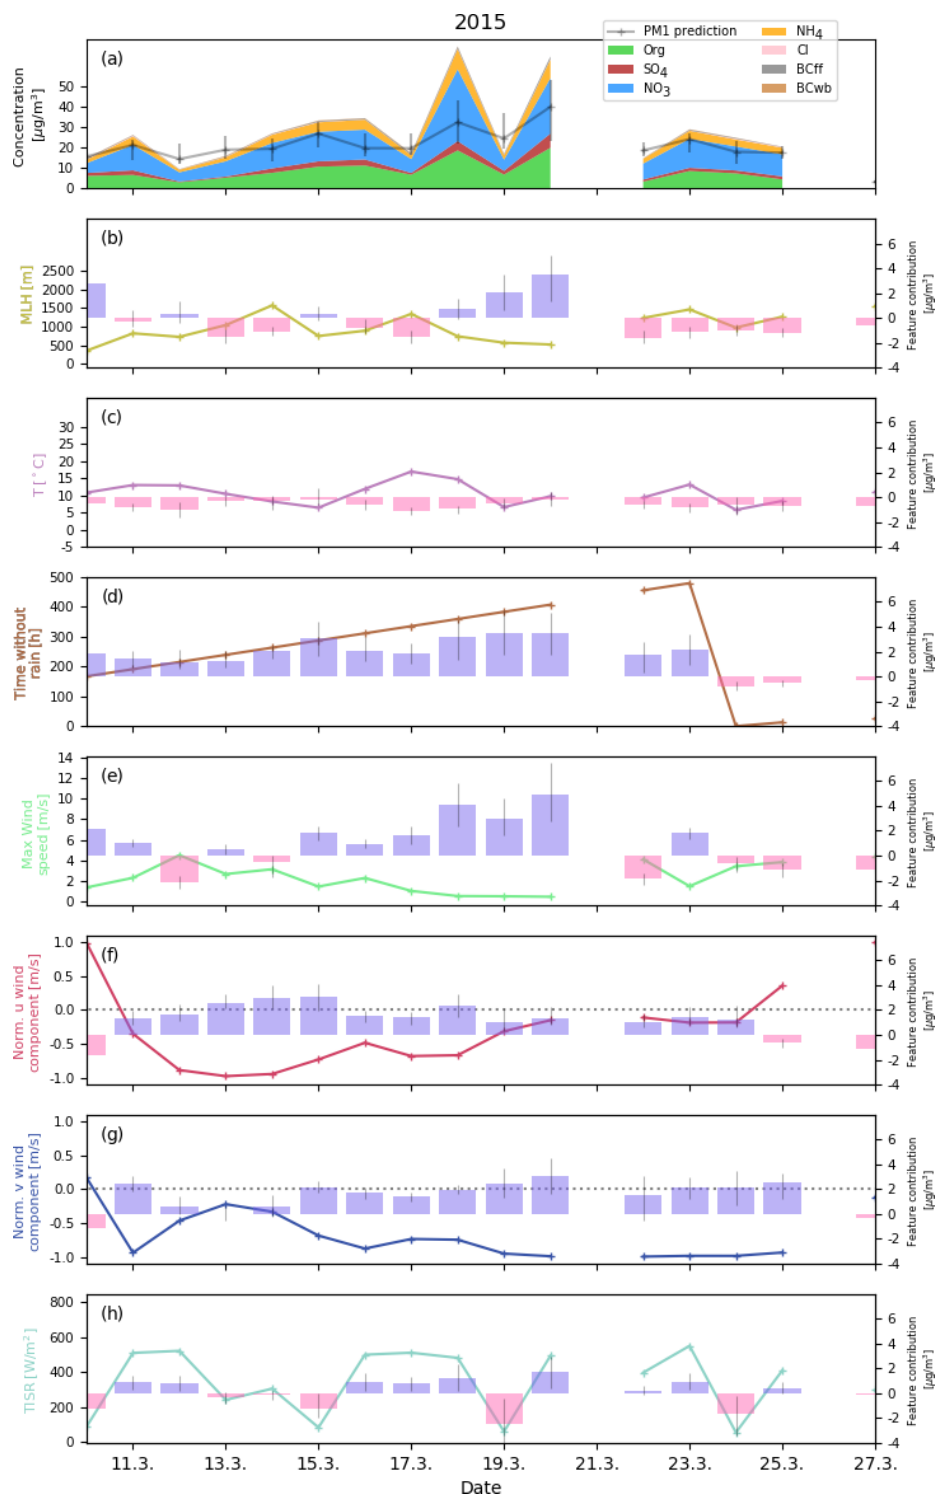
Figure 14. As Fig. 11 for an exemplary spring pollution episode in March 2015.